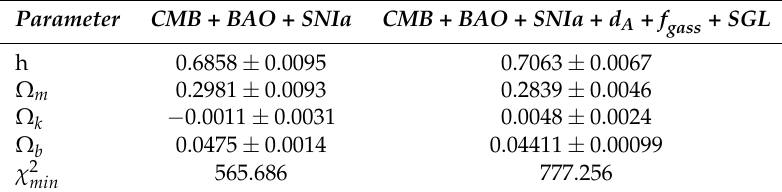
Table 1. Summary of the best fit values for Λ CDM model.